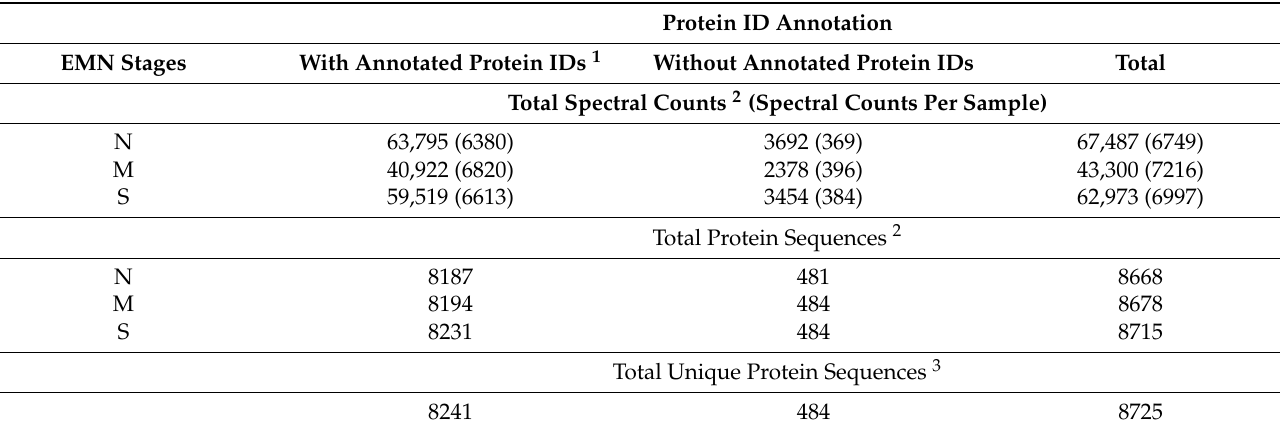
Table 2. Assigned spectral counts and unique protein